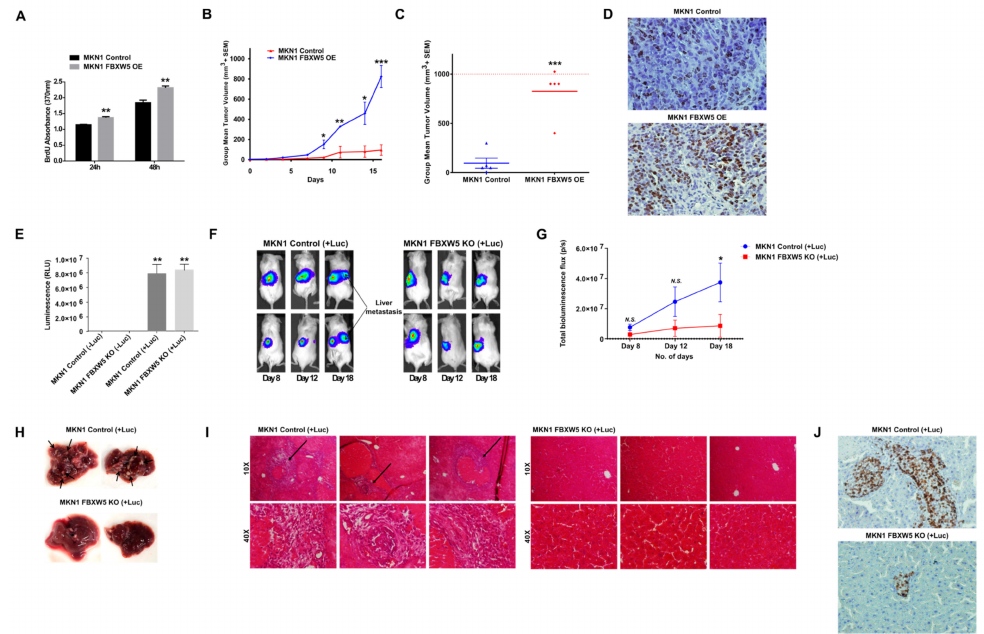
Figure 5. ( A ) Proliferation rates of MKN1 control and MKN1 FBXW5 OE cells analyzed by BrdU proliferation assay across two time points ( p -values = 0.004, 0.002, respectively). Values represent the average of two independent experiments and error bars denote standard deviations. ( B ) Mean tumor volume (mm 3 ) of MKN1 control and MKN1 FBXW5 OE cells at various indicated days over the course of 16 days ( p -values = 0.035, 0.009, 0.022, 0.001, respectively). ( C ) Mean tumor volume (mm 3 ) of MKN1 control and MKN1 FBXW5 OE cells at the end of 16 days (*** p -value = 0.001). ( D ) Immunohistochemical analysis of Ki67 expression in MKN1 control (top) and MKN1 FBXW5 OE (bottom) xenograft tissues. ( E ) Level of luminescence (RLU) of MKN1 control ( − /+ Luc) (** p -value = 0.0046) and MKN1 FBXW5 KO ( − /+ Luc) (** p -value = 0.003) cells. ( F ) Representative images of tumor metastasis in NOD-SCID mice intrasplenically injected with MKN1 control ( + Luc) or MKN1 FBXW5 KO ( + Luc) cells. Five animals were randomly assigned to each group and observed over the course of 18 days, with bioimaging performed on day 8, 12 and 18. ( G ) Quantification of bioluminescence imaging signal intensity in NOD-SCID mice intrasplenically injected with MKN1 control ( + Luc) or MKN1 FBXW5 KO ( + Luc) cells over the course of 18 days (* p -value = 0.0393). ( H ) Representative images of liver metastasis harvested from NOD-SCID mice intrasplenically injected with MKN1 control ( + Luc) or MKN1 FBXW5 KO ( + Luc) cells. Five animals were randomly assigned to each group and mice were sacrificed on day 18. ( I ) Representative images of haematoxylin and eosin (H&E) immunostaining of liver tissue sections prepared from NOD-SCID mice intrasplenically injected with MKN1 control ( + Luc) or MKN1 FBXW5 KO ( + Luc) cells. ( J ) Immunohistochemical analysis of Ki67 expression of liver tissue sections prepared from NOD-SCID mice intrasplenically injected with MKN1 control ( + Luc) (top) or MKN1 FBXW5 KO ( + Luc) (bottom) xenograft tissues. * p -value ≤ 0.05, ** p -value ≤ 0.01; *** p -value ≤